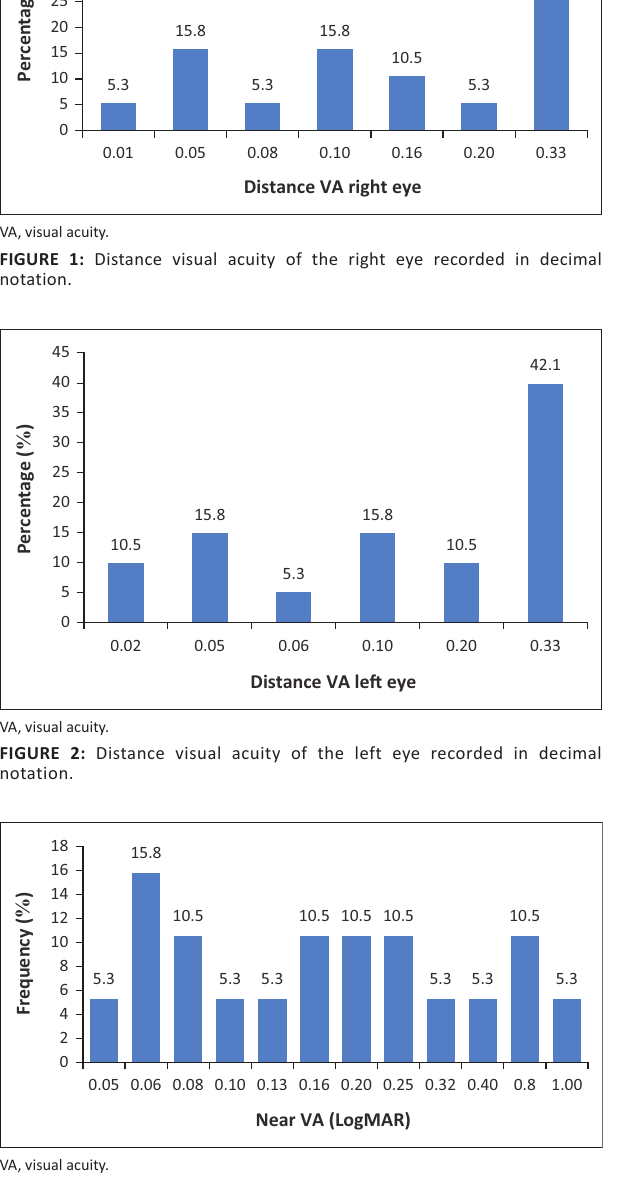
FIGURE 3: Near visual acuity recorded in